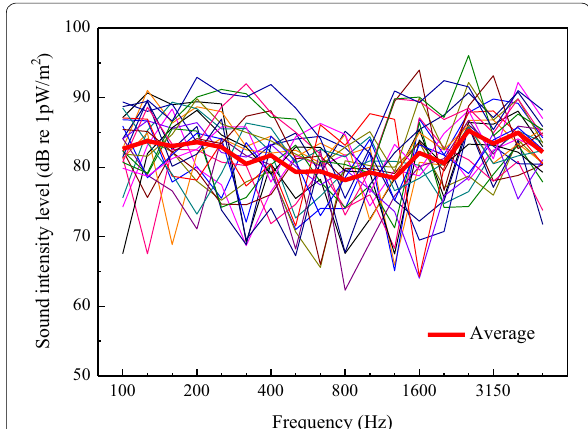
Figure 17 Sound intensity spectrum of the interior sidewall